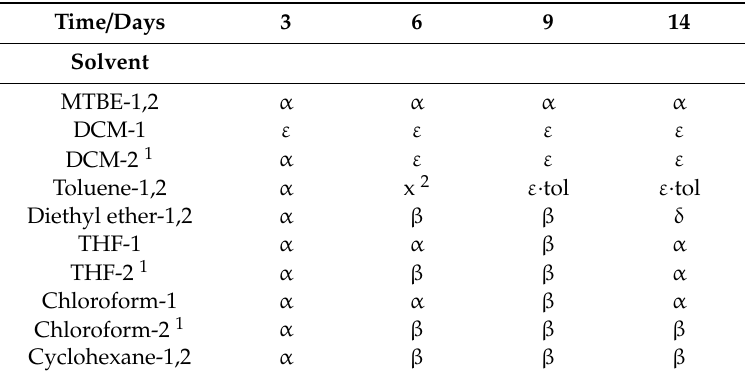
Table 2. Summary of the results from the stability evaluation of γ -CD-MOF-1 crystals in various solvents during two